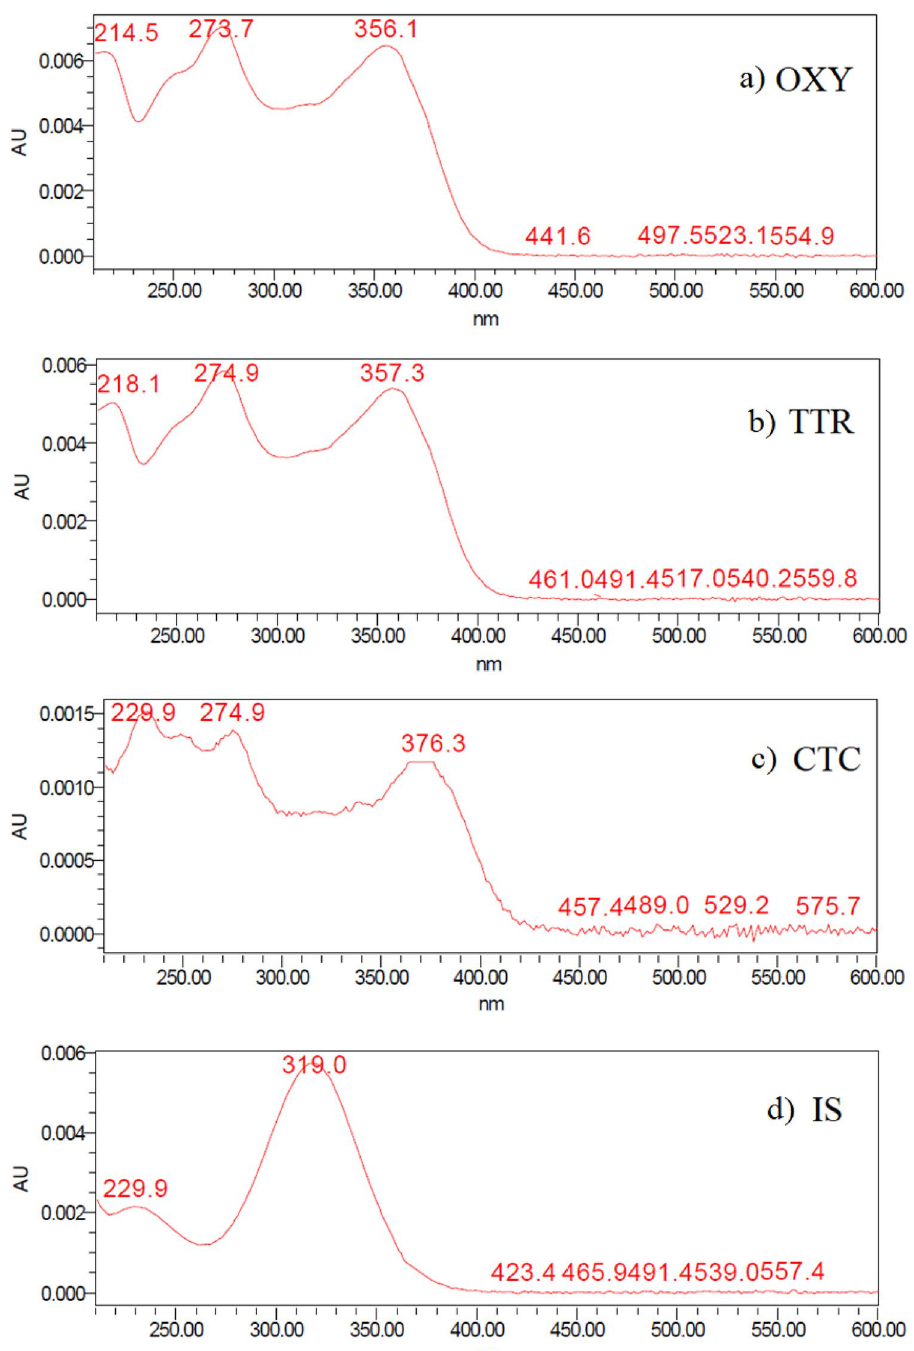
Figure 5. Absorbance spectra of the targeted analytes ( a ) Oxytetracycline, ( b ) Tetracycline, ( c ) Chlortetracycline and ( d ) Internal